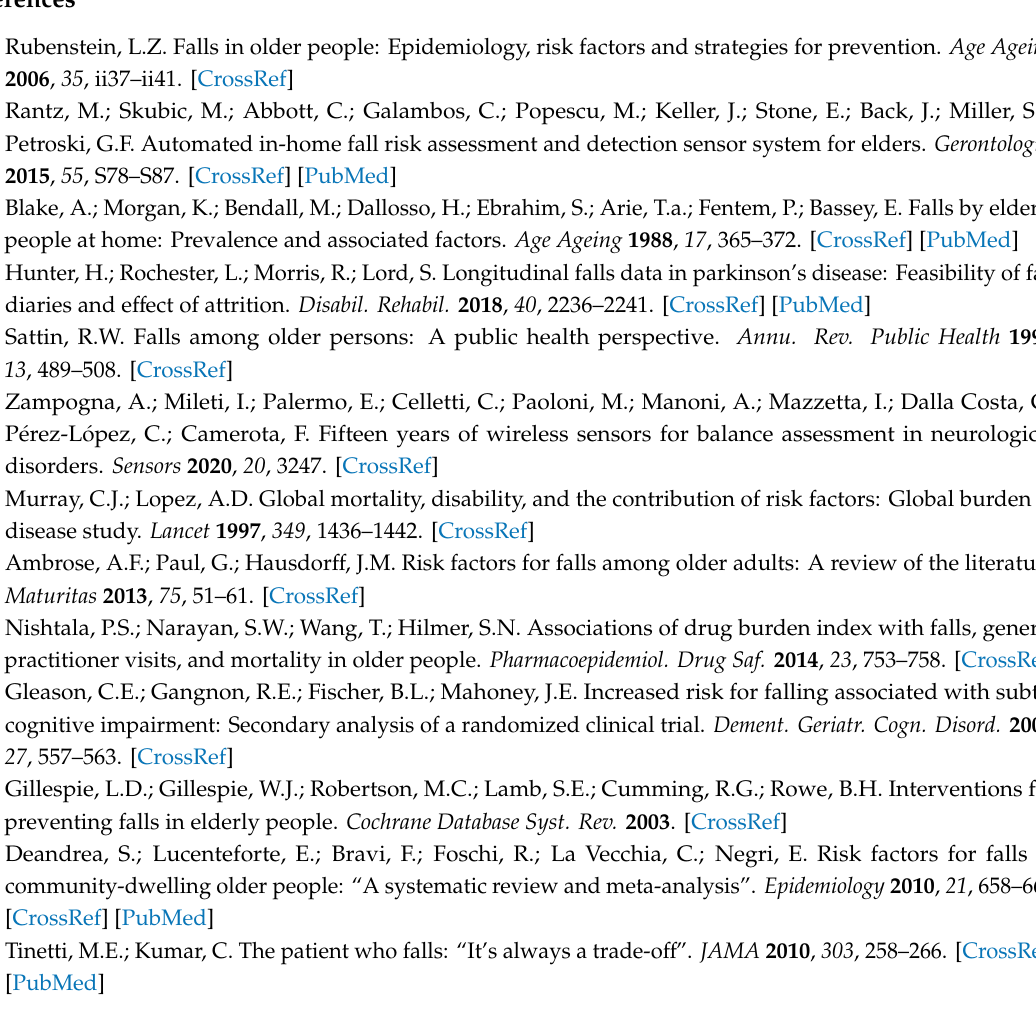
Figure A1. Piecewise linear path for signature extractions for training ML models.